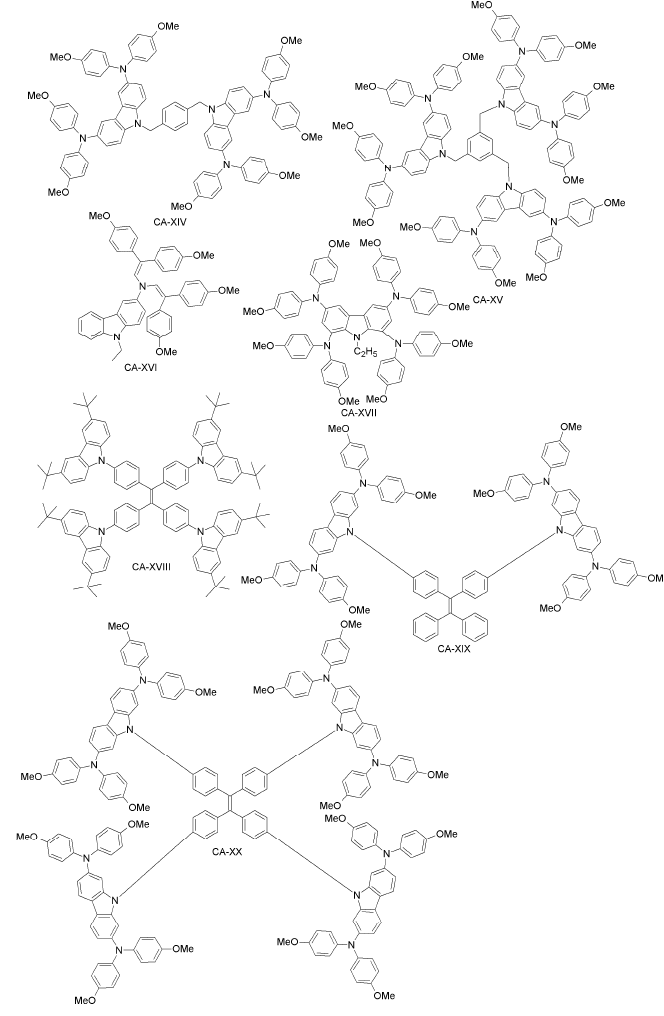
Figure 16. Carbazole-based HTMs (3).